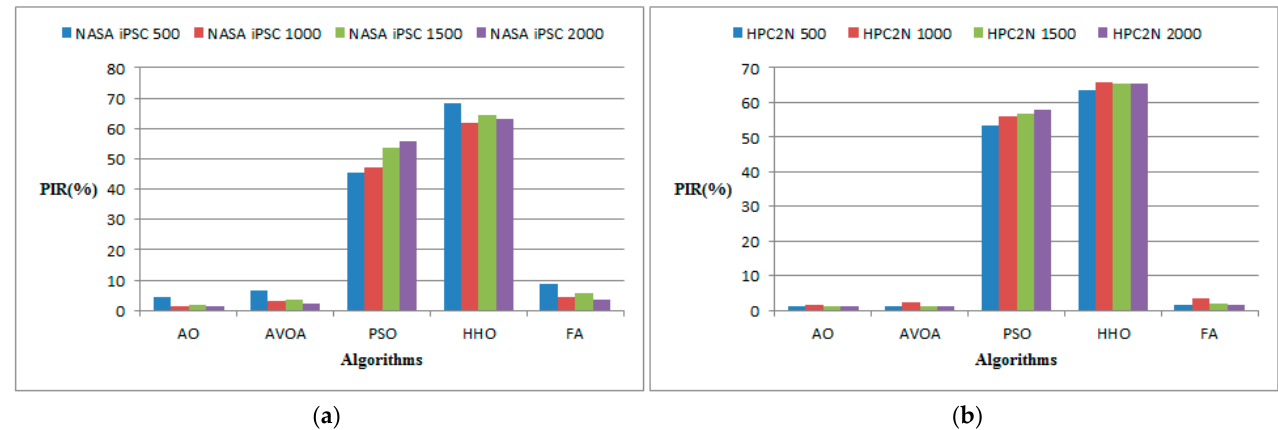
Figure 5. PIR (%) diagram of the makespan time for AO, AVOA, PSO, HHO, and FA for both datasets. ( a ) NASA iPSC dataset. ( b ) HPC2N dataset.